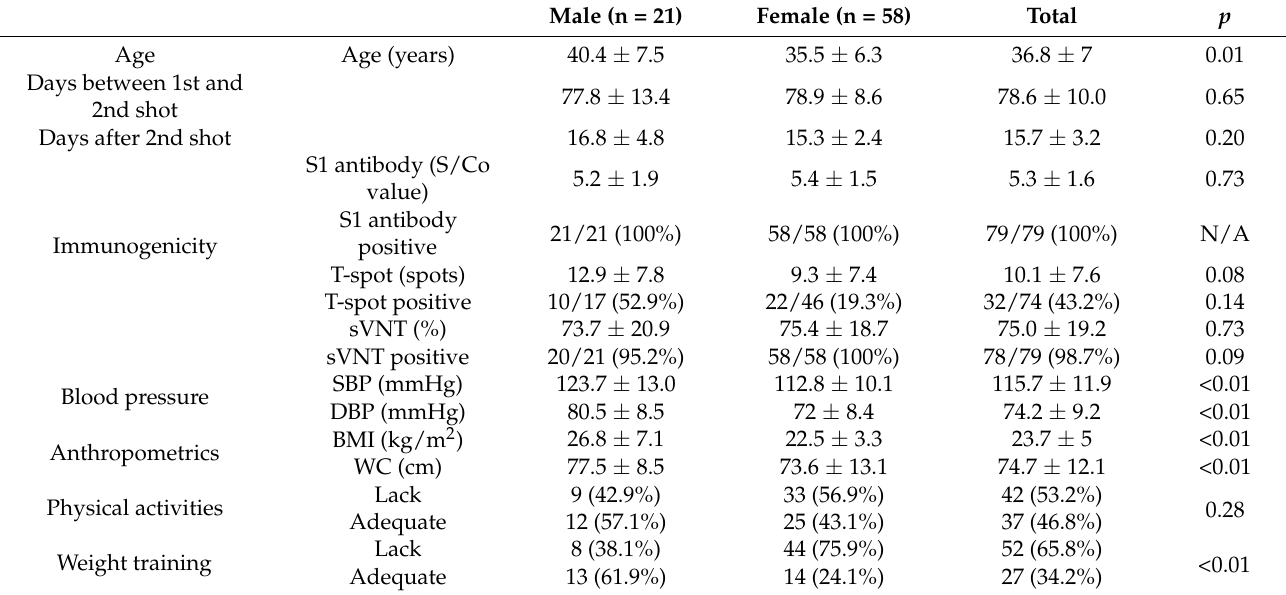
Table 1. Characteristics of study participants according to sex and their differences on variables (n =